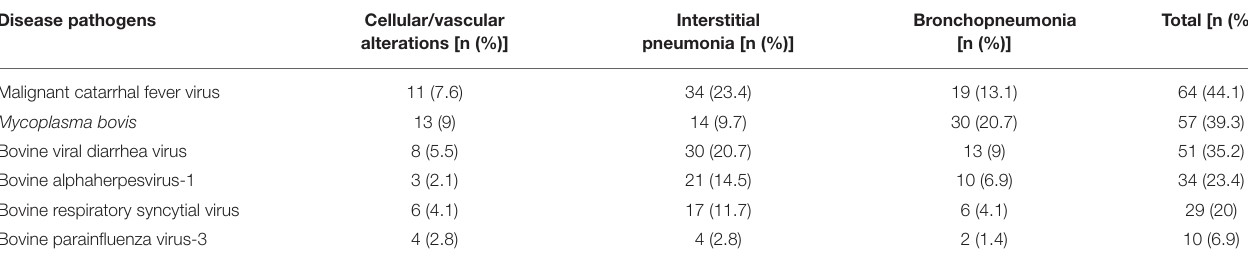
TABLE 3 | Occurrence of respiratory pathogens, according to the pulmonary categories evaluated ( n = 145) a . Disease pathogens